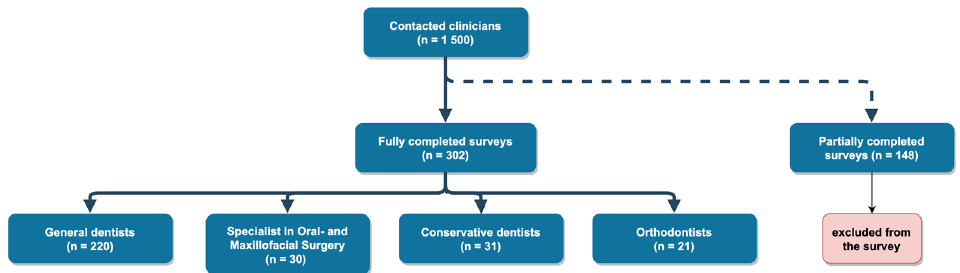
Figure 1. Flow chart describing the compilation of the survey participants.